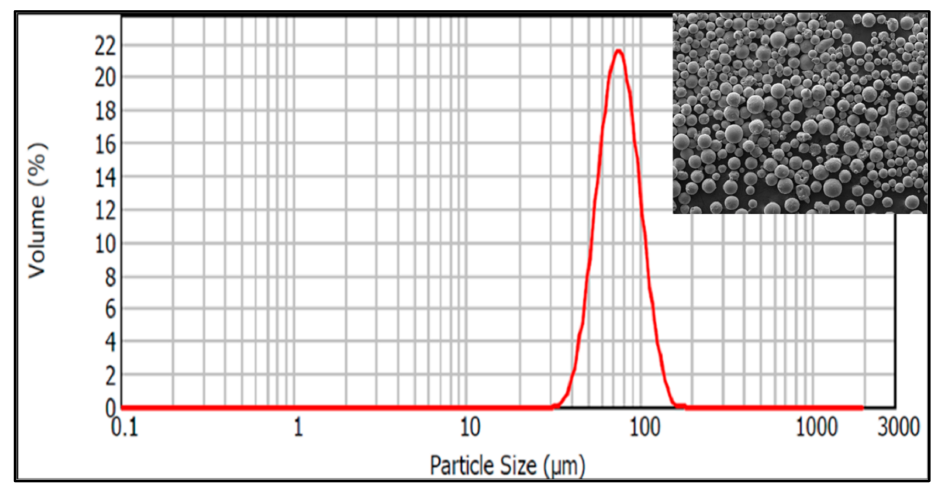
Figure 9. Laser diffraction technique used to study the powder size